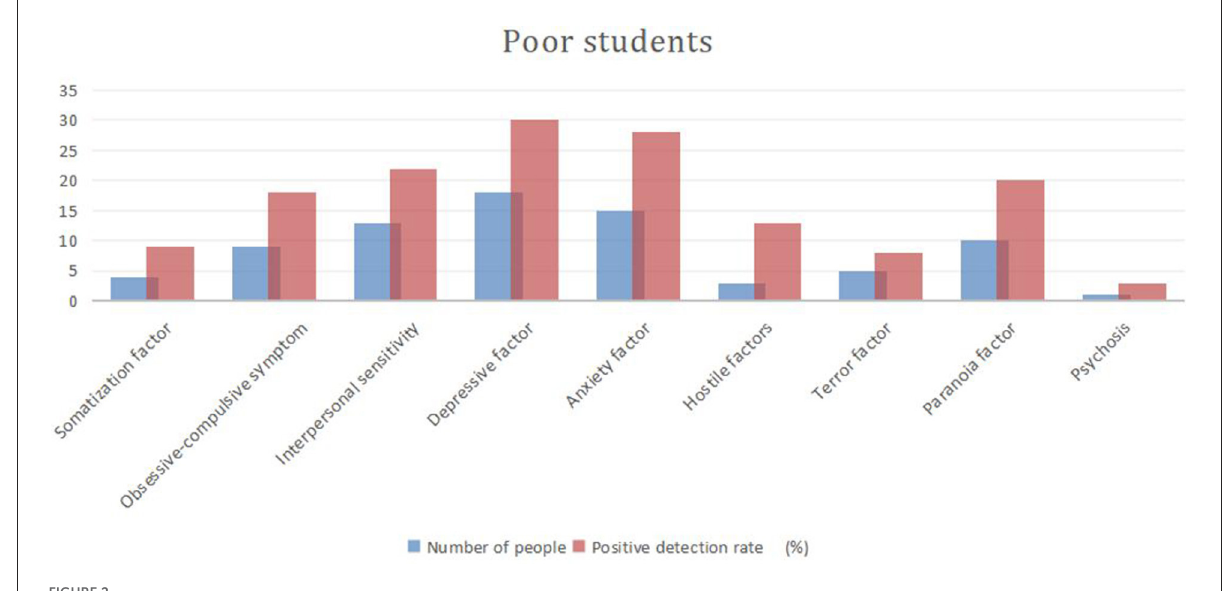
FIGURE2 Positive detection rates of SCL-90 factors among needy students.